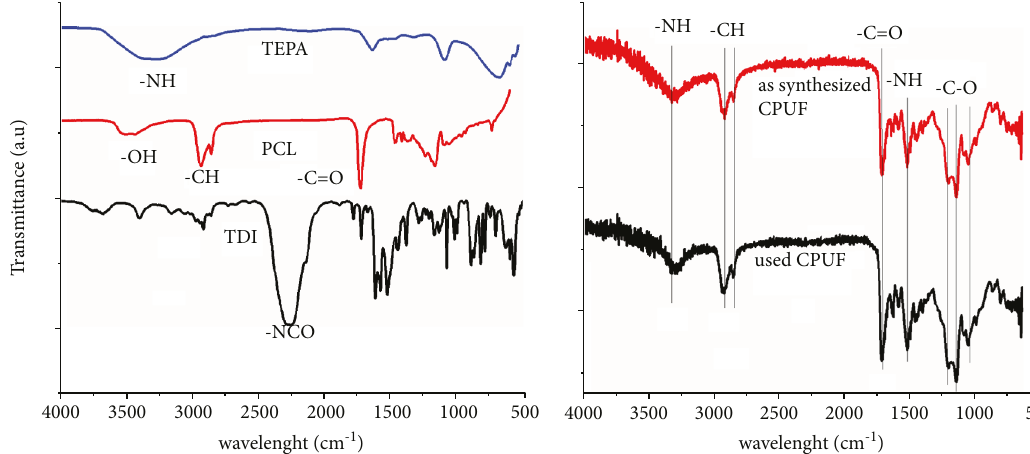
Figure 1: FTIR spectra of monomers (TDI, PCL, and TEPA) and cross-linked polyurethane foam (CPUF) as (a) synthesized CPUF and (b) used CPUF.